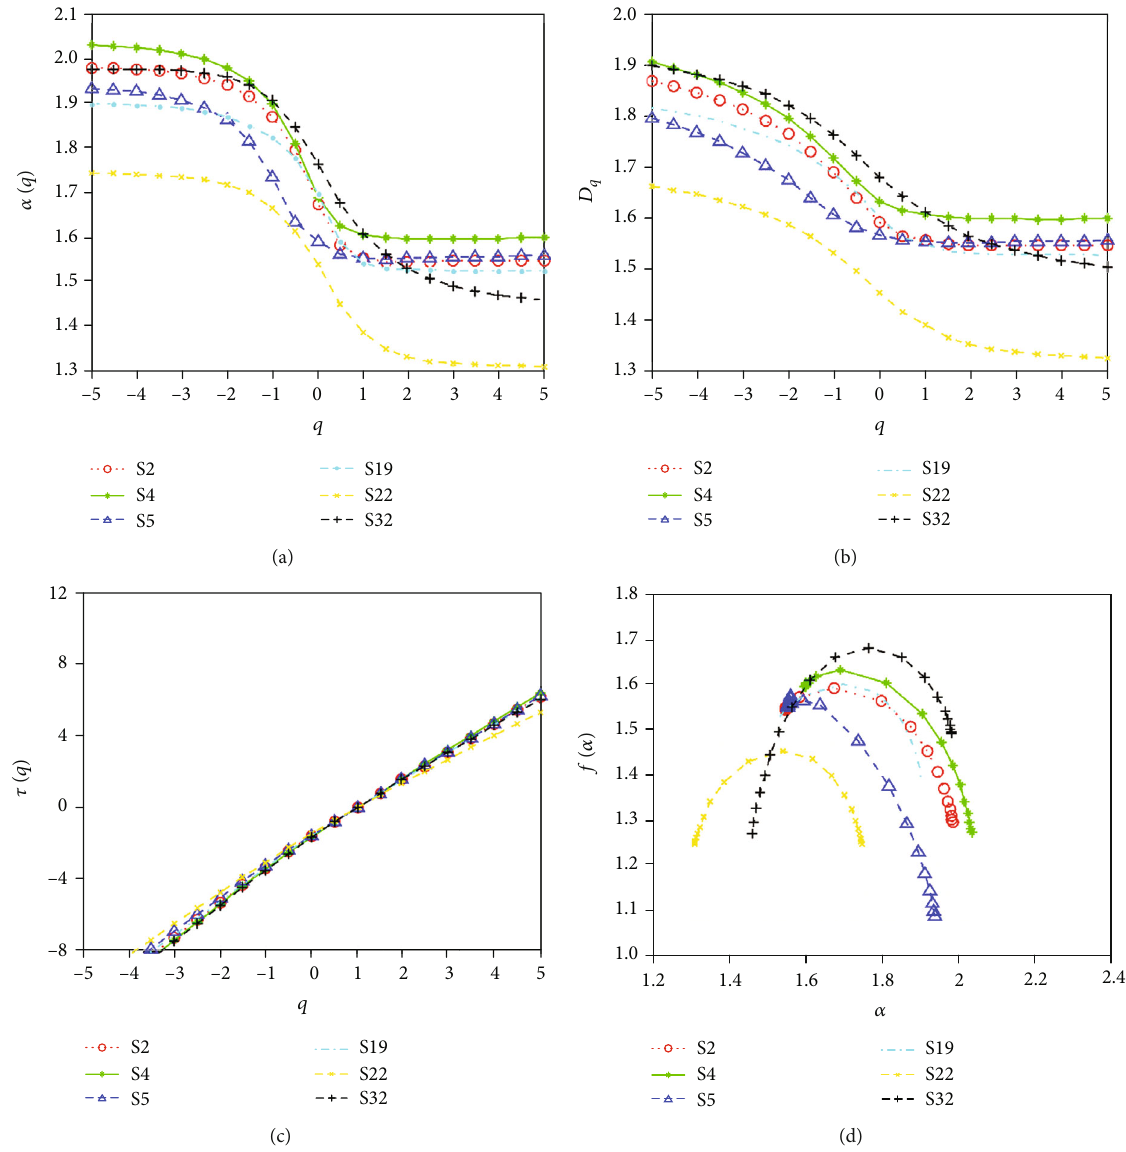
Figure 5: Multifractal analysis of pores in dolomite for samples S2, S4, S5, S19, S22, and S32. (a) Plots of singularity exponents against moments q . For each sample, the α ð q Þ decreases against the increase of q . (b) Plots of D q changing with q . (c) Plots of mass exponent varying with the moment q . (d) Multifractal spectrum of the Hausdor ff dimension f ð a Þ changing with singularity exponent α